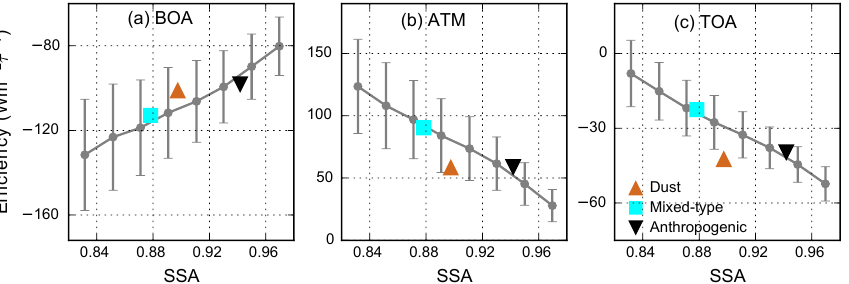
Figure 8. Direct aerosol radiative efficiency as a function of SSA for the dust, mixed-type and anthropogenic aerosols: (a) BOA, (b) ATM, and (c)